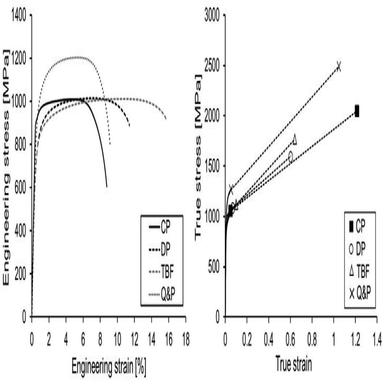
Engineering and true stress-strain curves. The symbols correspond to the true uniform strain and the true fracture strain.